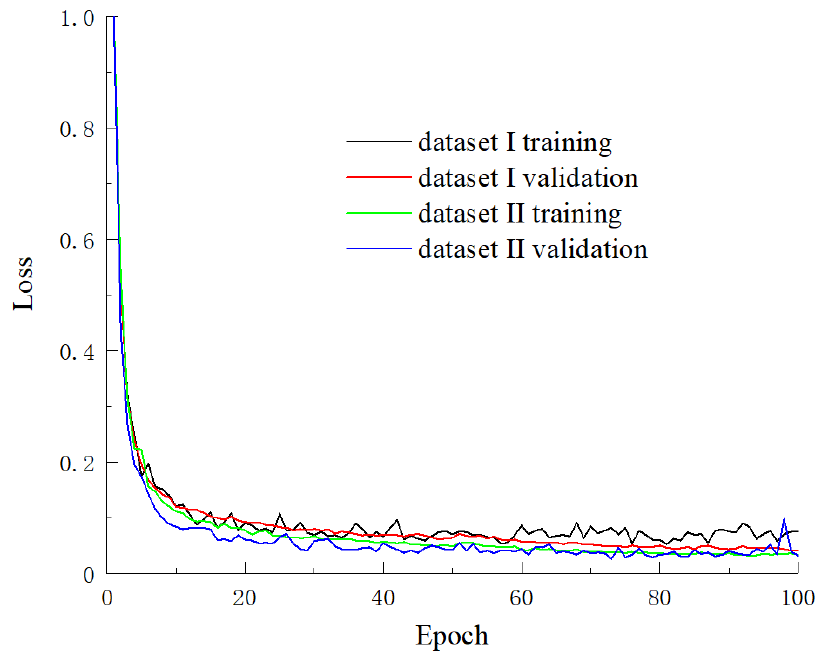
Figure 8. Training losses of the deep learning network with training datasets I and